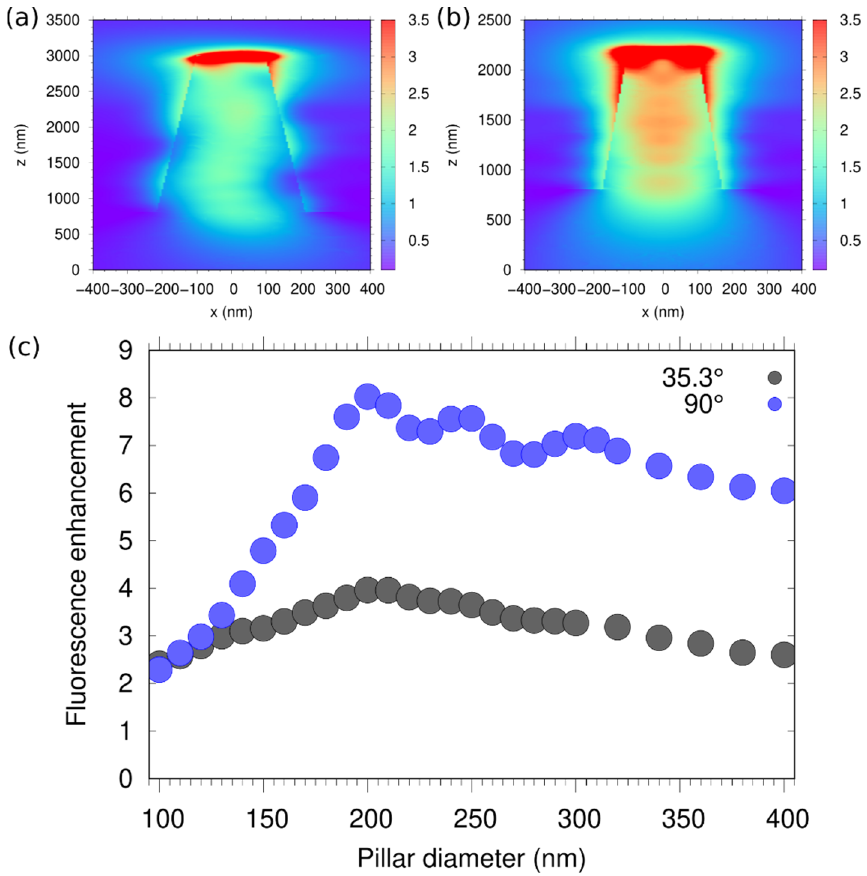
Figure 4. Electric field distribution of incoherently superimposed dipoles oriented in an angle θ of 35.3° ( a ) and 90° ( b ) with respect to the surface normal. ( c ) Enhancement of the emitted fluorescence into the objective (NA = 0.95) as a function of the pillar diameter compared to the corresponding collection of dipoles below a flat interface ( θ = 35.3°).